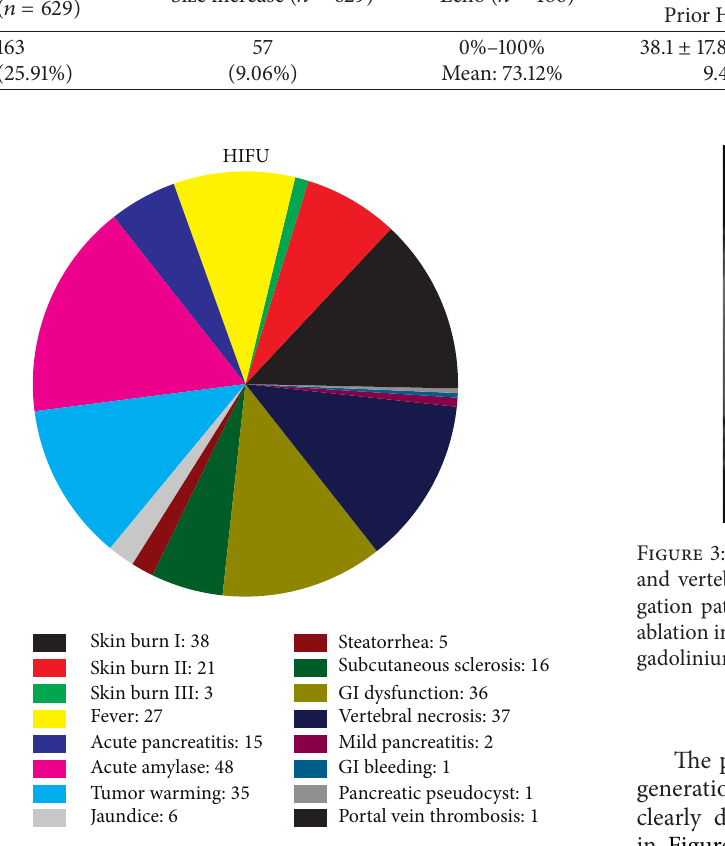
Figure 2: Summary of the complications found in HIFU ablation for advanced pancreatic cancer.